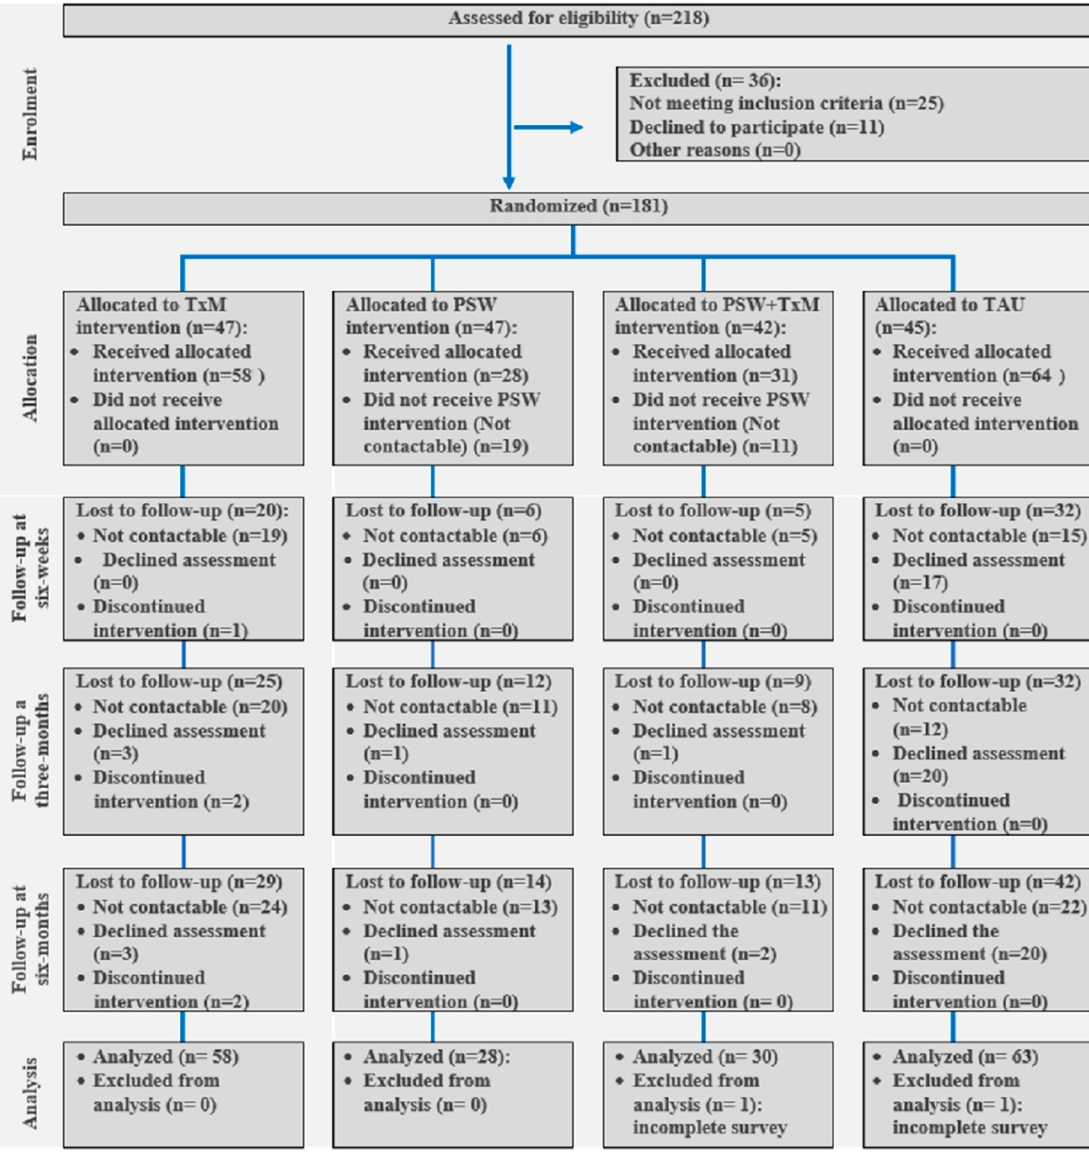
Figure 1. Study flow chart.